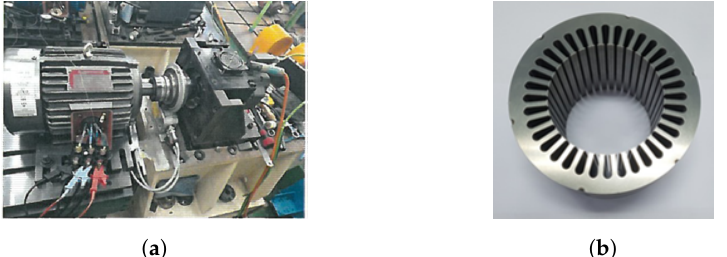
Figure 4. Experimental setup of the 2.2 kW induction motor is shown in ( a ), and ( b ) show annealed stator